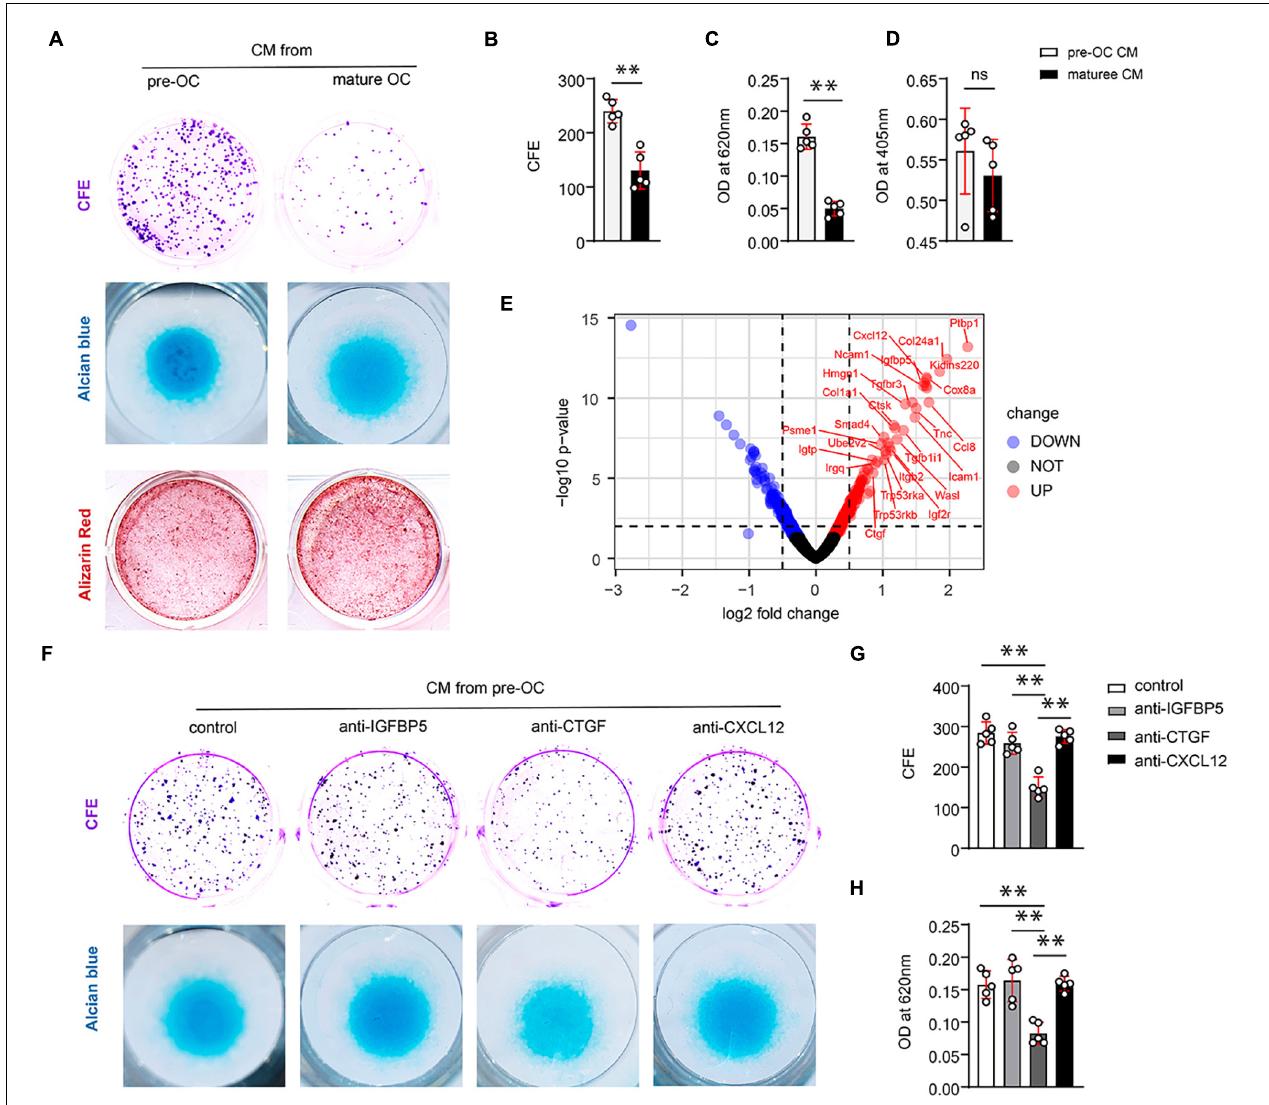
FIGURE 2 | CTGF from preosteoclasts induces periosteal stem cells (PSCs) renewal and promotes the chondrogenic potential of PSCs in vitro. (A) Representative images of clone formation efficiency (CFE), alcian blue, and alizarin red staining of PSCs. (B) Quantitative analysis of the CFE of PSCs. (C) Quantitative analysis of alcian blue staining 620 nm absorbance. (D) Quantitative analysis of alizarin red staining at 405 nm absorbance. (E) Volcano map of differentially expressed proteins in the extracellular matrix after adding TRAP + monocytes. Neutralizing antibodies of IGFBP5, CTGF, and CXCL12 were added to the conditioned medium of preosteoclasts and mature osteoclasts to investigate their effects on PSCs self-renewal and chondrogenesis. (F) Representative images of clone formation efficiency (CFE) and Alcian blue. (G) Quantitative analysis of the CFE of PSCs. (H) Quantitative analysis of Alcian blue staining 620 nm absorbance. Data are shown as mean ± SD. ∗∗ P <